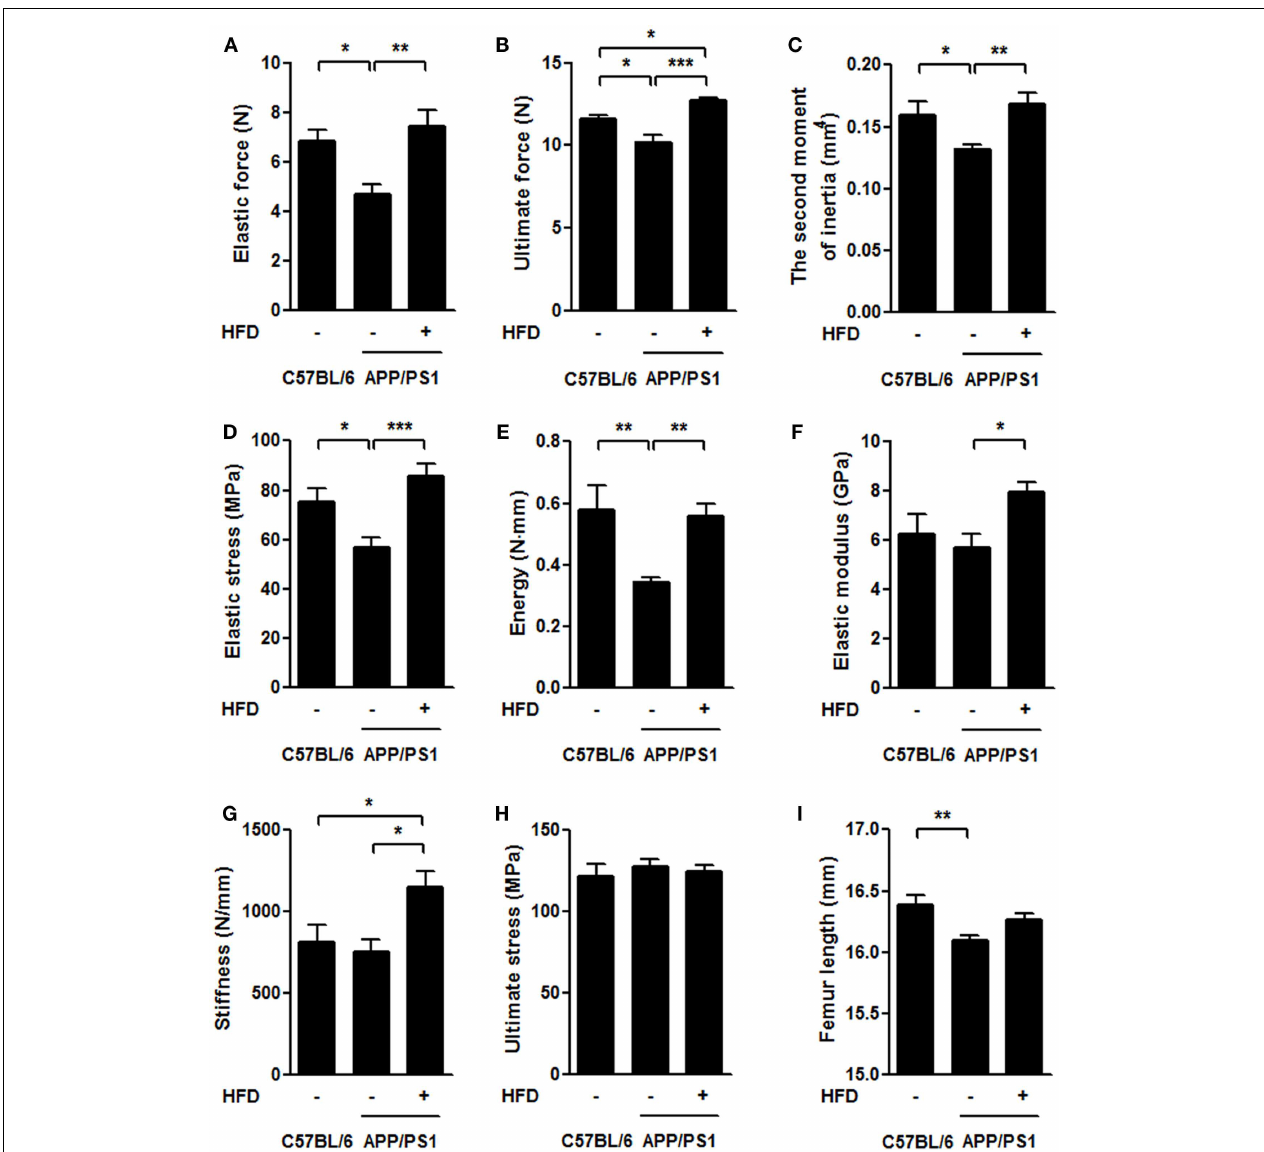
FIGURE 4 | HFD ameliorated impairments of femoral mechanical properties inAPP/PS1 mice . In the three-point bending test, the elastic force (A) , ultimate force (B) , second moment of inertia (C) , elastic stress (D) , and energy (E) were all significantly reduced in APP/PS1 mice compared to the age-matched C57BL/6 mice. No difference was found in elastic modulus (F) and stiffness (G) between C57BL/6 and APP/PS1 mice, but